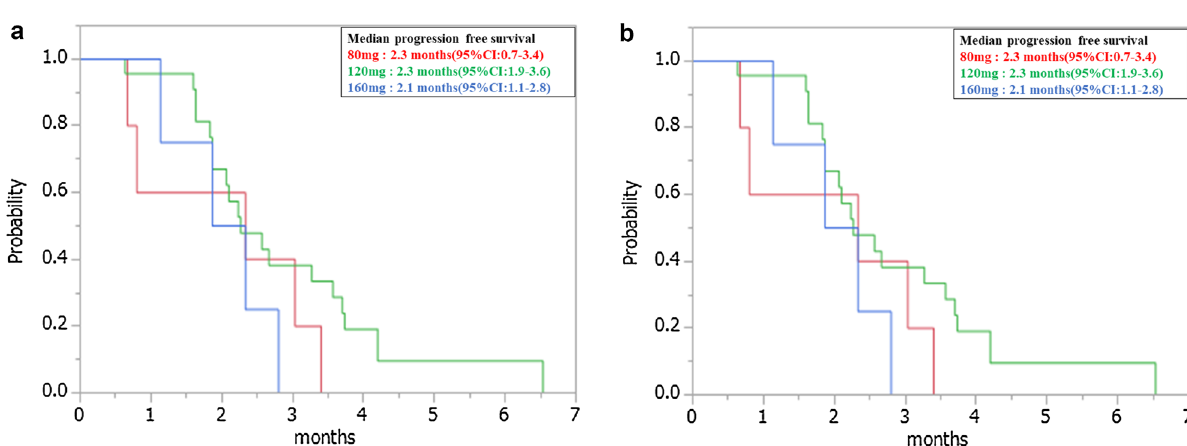
Figure 4. Kaplan–Meier plots of ( a ) progression-free survival (PFS) and ( b ) overall survival (OS) among study participants. Red line: 160 mg group; Green line: 120 mg group; Blue line: 80 mg